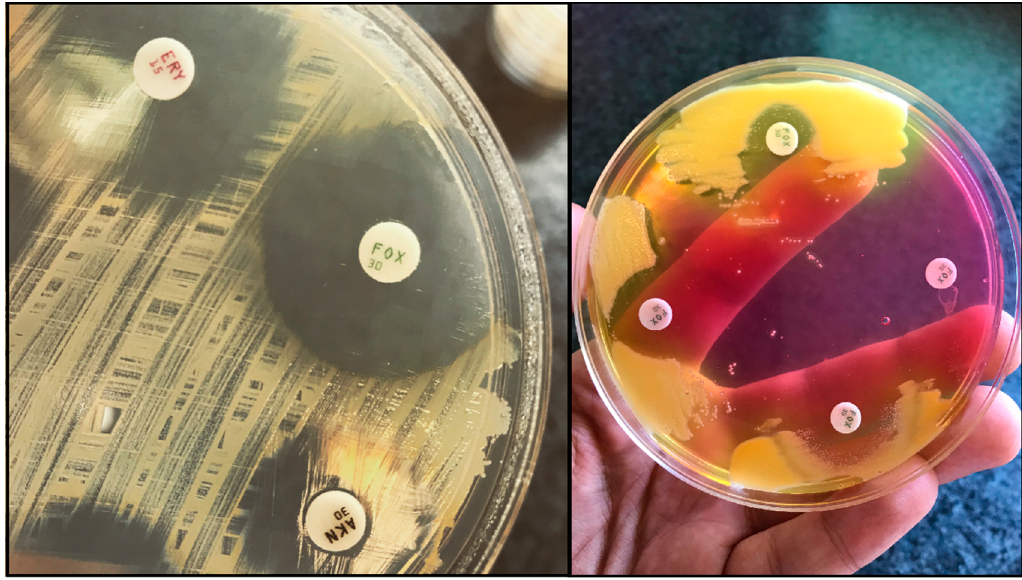
Figure 1. Cefoxitin-susceptible S. aureus on Mueller-Hinton-agar (antibiotic susceptibility-testing based on the Kirby-Bauer method) ( left ), Methicillin-resistant S. aureus (MRSA) screening using mannitol-salt agar (MSA) using cefoxitin disks ( right ).